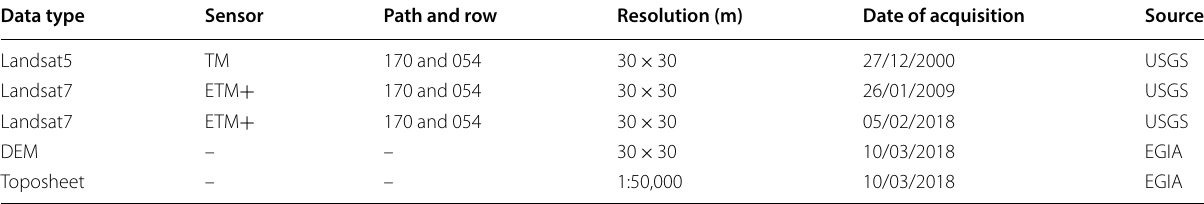
Table 1 Data types, sources and their description Data type